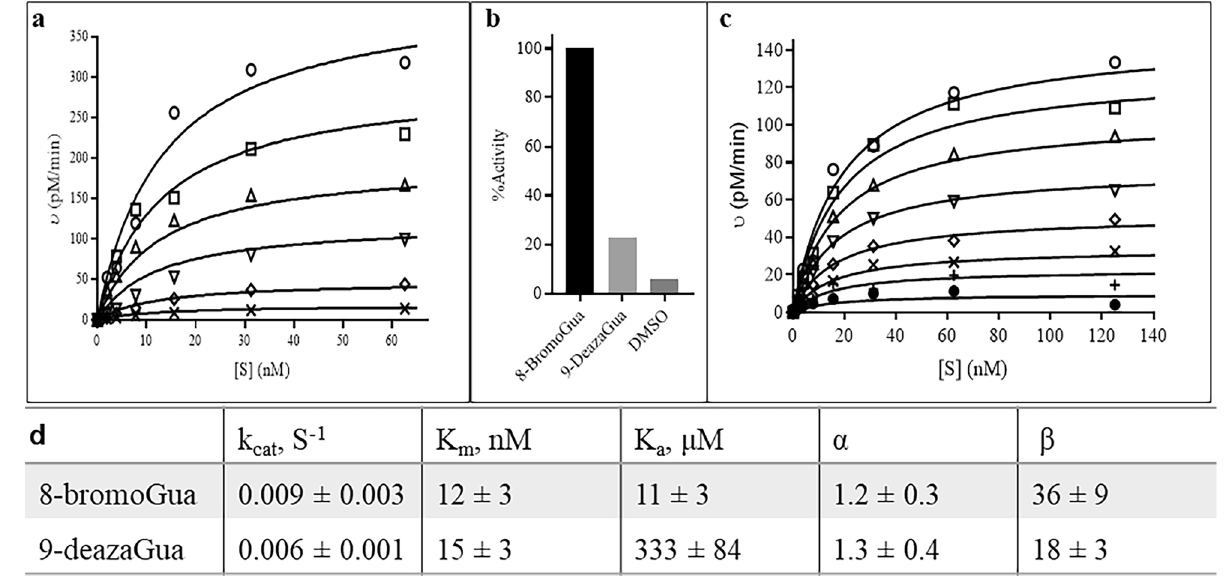
Figure 3. Activation of OGG1 by 8-bromoGua and 9-deazaGua. The term [S] refers to substrate A displayed in Supplementary Fig. S1. Values were obtained in duplicate from an independent experiment by varying substrate concentration over time. In ( a ) OGG1 (at 10 nM) initial rates were measured as a function of substrate A concentration listed on the x-axis in the presence of 8-bromoGua at 0.0 (×), 0.63 ( ♢ ), 2.5 ( ▽ ), 5 ( △ ), 10 ( ◻ ), and 20 ( ○ ) μM. Kinetic parameters from analyzing the data using Eq. (2) were used to calculate the theoretical values (solid lines). ( b ) Bar plot of OGG1 activity in the presence of 200 μM 8-bromoGua and 9-deazaGua. Data were normalized to OGG1 activity in the presence of 200 μM 8-bromoGua. ( c ) Similarly, to panel ( a ), plots of OGG1 (at 10 nM) initial rates as a function of substrate A concentration (x-axis) in the presence of 9-deazaGua at 0.0 ( ● ), 39 (+), 78 (×), 156 ( ♢ ), 313 ( ▽ ), 625 ( △ ), 1250 ( ◻ ), and 2500 ( ○ ) μM. ( d ) Kinetic parameters from analyzing the data using Eq. (2) (Supplementary Table 2) were used to calculate the theoretical values (solid lines). Standard deviation of the fit of the lines provides the error 19 F NMR line‑broadening analysis demonstrates binding of Compound VI to free OGG1. Com- pound VI, which contains a fluorine atom, was used in a 19 F NMR analysis to detect compound binding to the free enzyme. Figure 4a shows that in the presence of OGG1 and a concentration range close to and above the EC 50 for Compound VI (up to 24 μM), the 19 F NMR resonance was broadened while also being shifted up field. This finding demonstrates that this compound binds to the OGG1 protein in the absence of a DNA substrate. Figure 4b shows a displacement experiment with compound VII in the presence of compound VI and OGG1. The line narrowing observed on the 19 F NMR resonance of compound VI suggests that compound VII competes for the same binding site as compound VI . Similar results were obtained with compounds VIII-X as shown in Fig. 4c which illustrates the line narrowing effect through the peak height of the 19 F NMR resonance of com- pound VI . These results further support an allosteric activation mechanism.